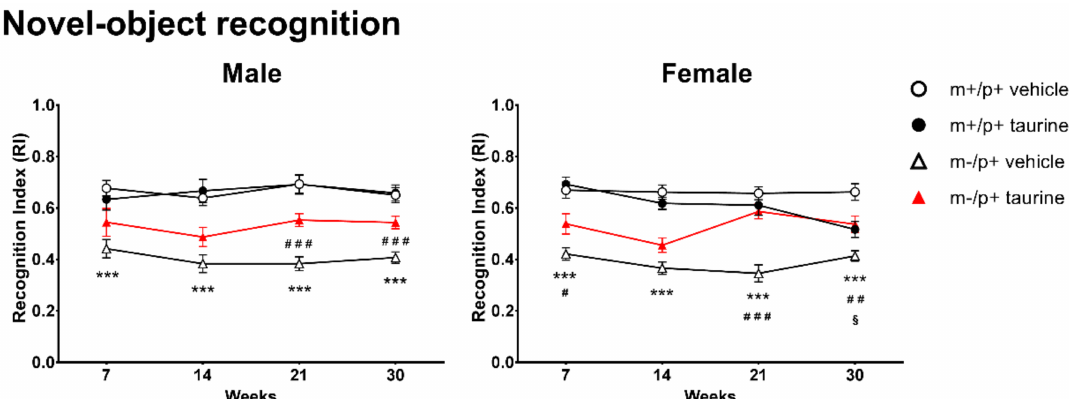
Figure 4. Taurine treatment improved learning and memory in AS ( Ube3a m − /p+ ) mice. Novel object recognition test was carried out at four time points (7, 14, 21 and 30 weeks) on wild type (WT) and Ube3a m − /p+ mice (both treated (taurine) and untreated (vehicle)). Analyses were conducted by separating genders (male: left panel ; female: right panel ). Number of animals per group: male mice (wt + vehicle = 14, wt + taurine = 11, Ube3a m − /p+ + vehicle = 14, Ube3a m − /p+ + taurine = 13); female mice (wt + vehicle = 12, wt + taurine = 14, Ube3a m − /p+ + vehicle = 12, Ube3a m − /p+ + taurine = 14). Data are shown, for each time point, as media ± SEM. Effect of genotype: *** p < 0.001; effect of taurine treatment on Ube3a m+/p+ genotype: § p < 0.05; effect of taurine treatment on Ube3a m − /p+ genotype: # p < 0.05, ## p < 0.01, ### p < 0.001.